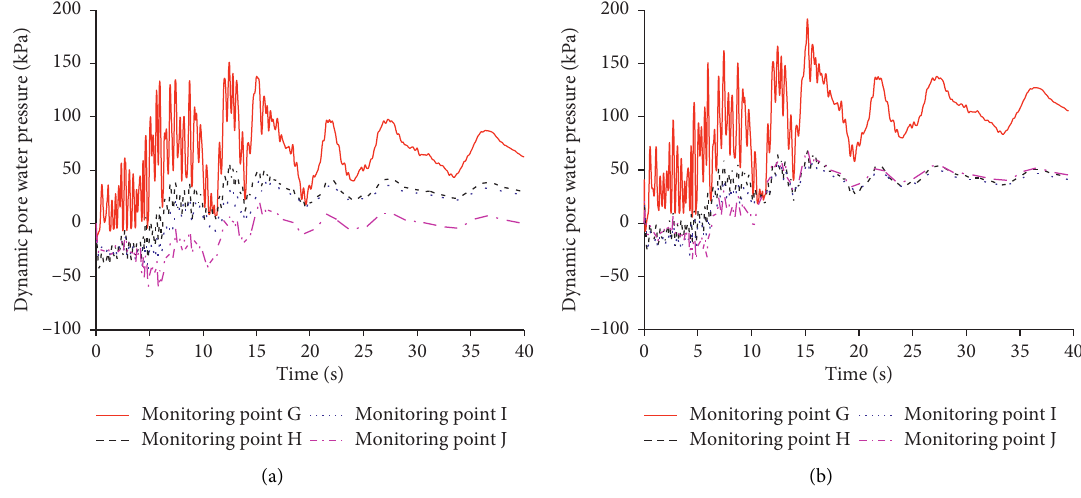
Figure 14: The dynamic pore water pressure under T2-II-1. (a) 14m. (b)